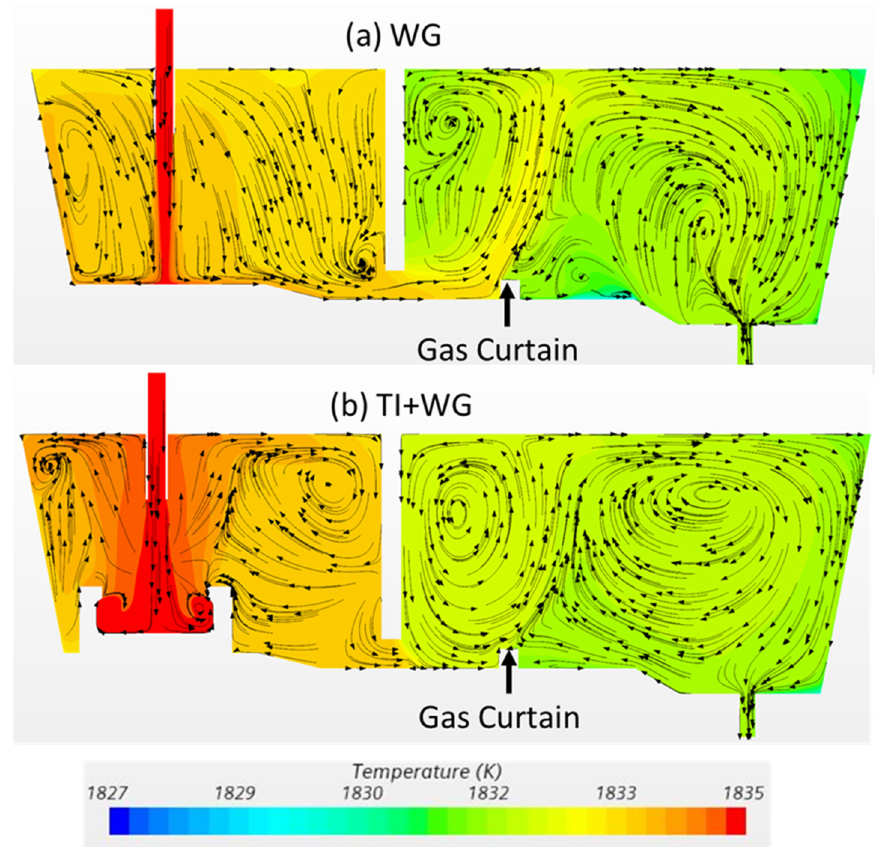
Figure 13. Fluid flow and temperature distributions in tundish for two multiphase cases with different configurations: ( a ) WG; ( b ) TI + WG.